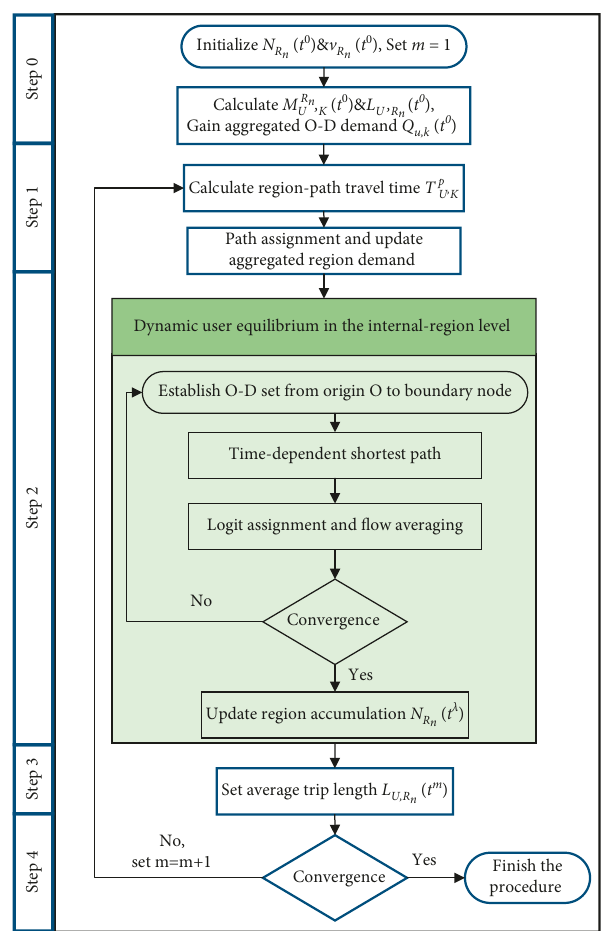
Figure 1: Methodological framework.